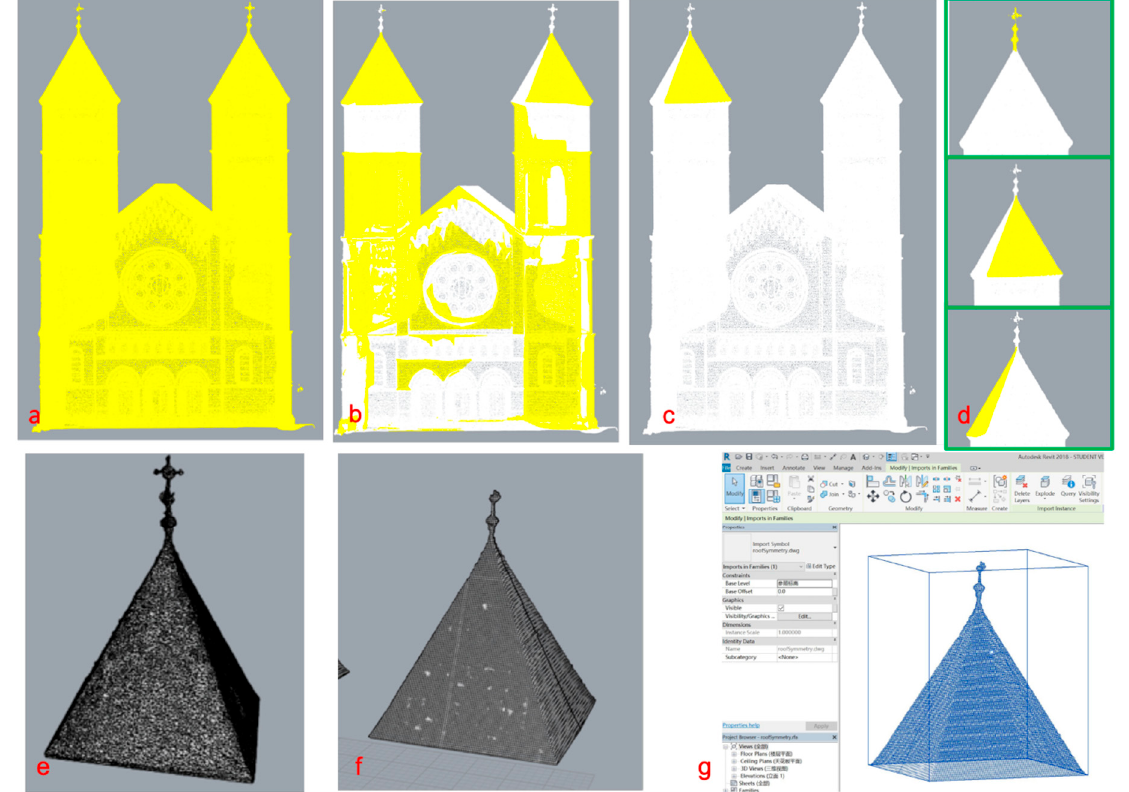
Figure 4. The explosion processing to segment the holistic mesh ( a ) into small blocks by a multi-layered explosion ( b , c ). The primitive representing the church’s primary component is then generated based on the merging of several small blocks ( d ). The surface mesh ( e ) is converted to NURBS curve based solid geometry by adding thickness ( f ) and translated in a BIM environment ( g ).